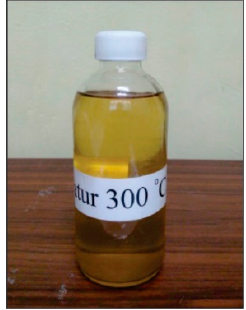
Figure 3. Pictorial view of produced WPO.